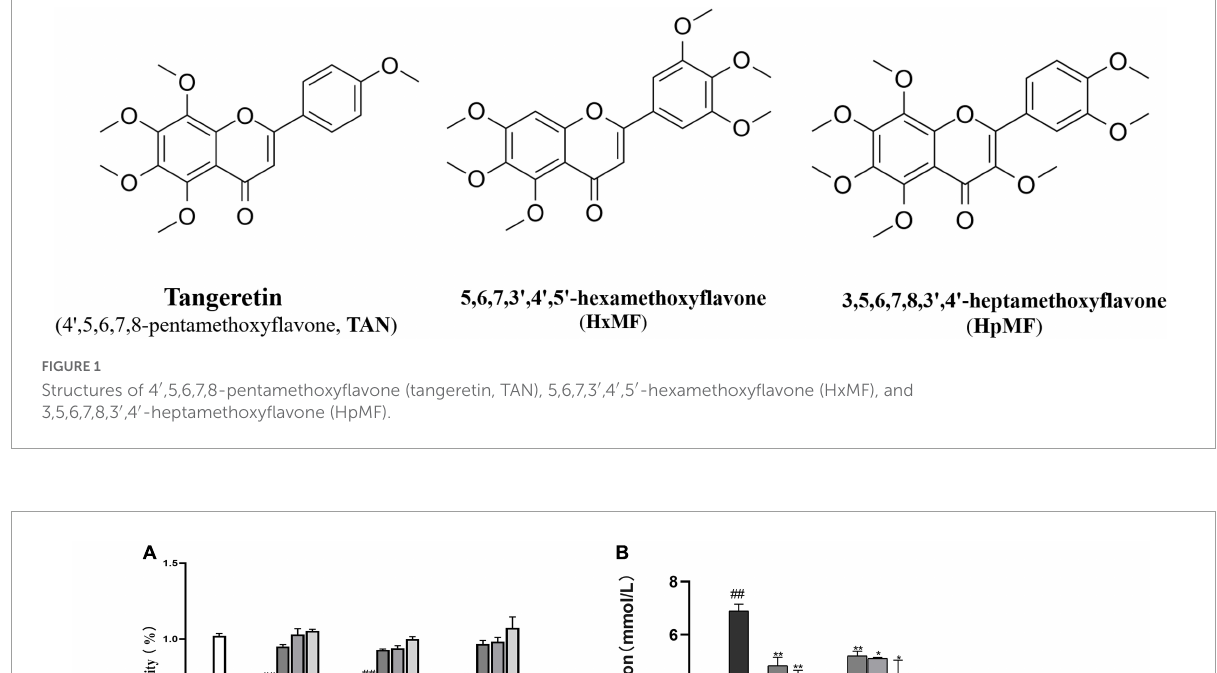
Frontiers in Cardiovascular Medicine